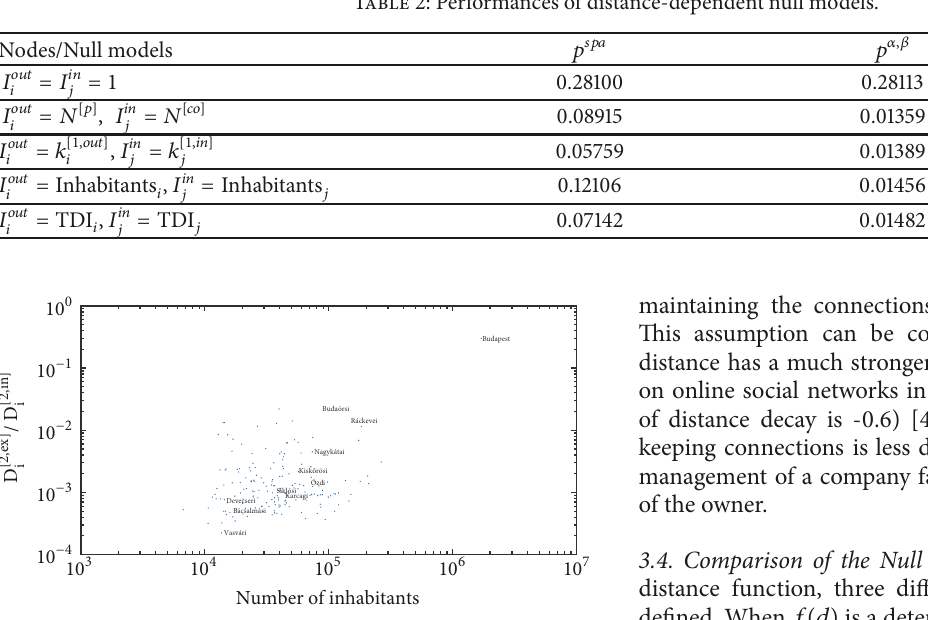
Figure 4: Openness of small regions (LAU 1 level) as a function of the number of their inhabitants.